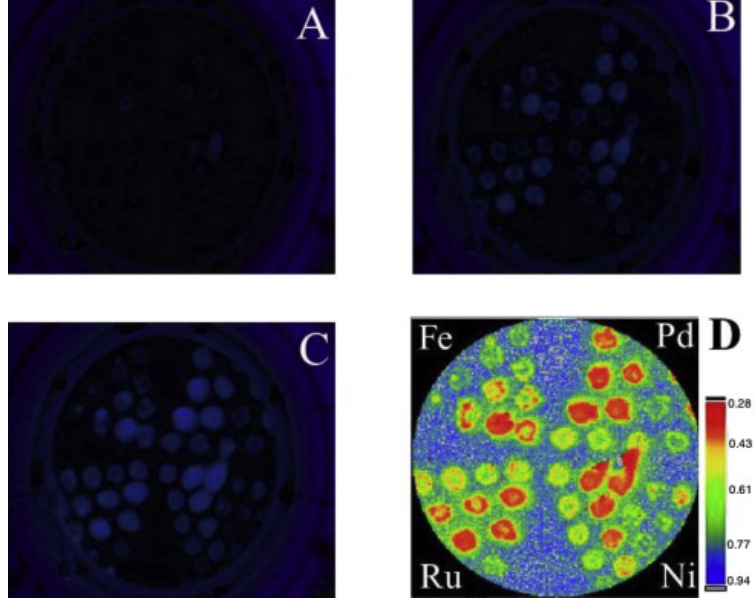
Figure 10. Combinatorial array and screening results by fluorescence imaging of PtSnM electrode arrays in 6.0 M ethanol and quinine fluorescent indicator. Active compositions for ethanol electro-oxidation are shown as bright spots: fluorescence image at ( A ) lower overpotential (~0.27V vs. RHE); ( B ) intermediate overpotential (~0.46 V vs. RHE) and ( C ) high overpotential (~0.93 V vs. RHE); ( D ) Fluorescence onset potential for ethanol electro-oxidation on PtM and PtSnM library. Reproduced with permission from Reference [101]. Copyright 2015,